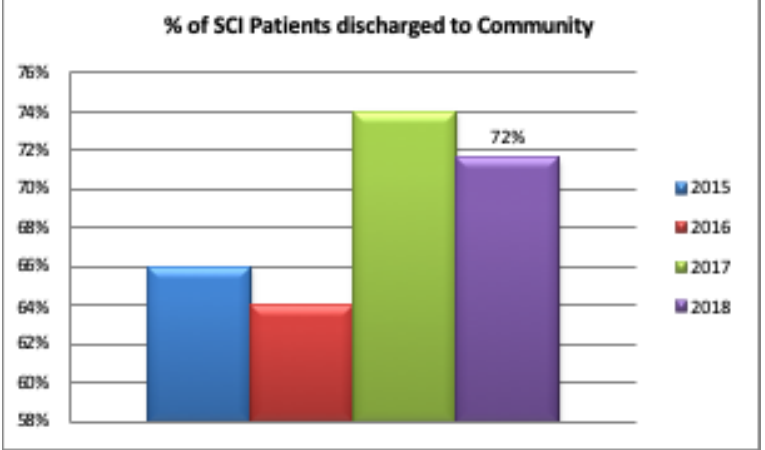
Figure 3. The percentage of patients discharged to the community from 2015 through